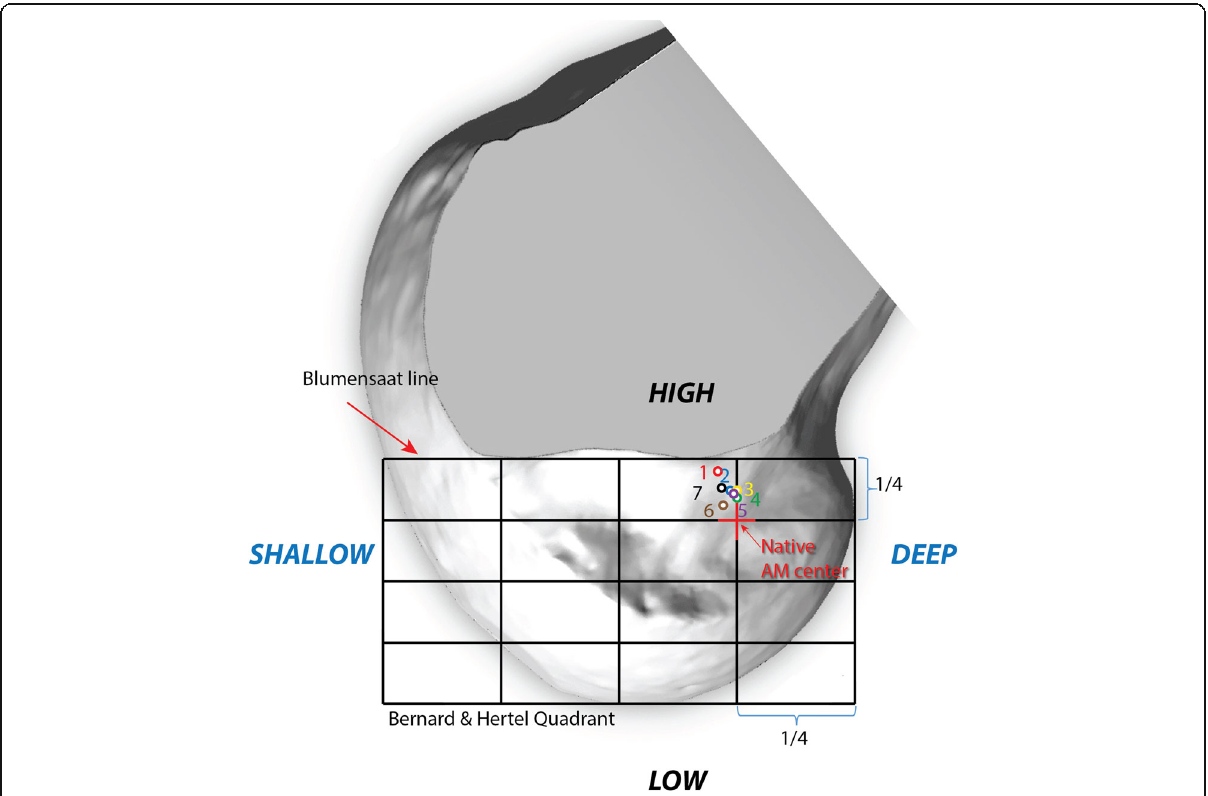
Fig. 6 Right femur: mapping each tunnel center measures (1 to 7). The Bernard & Hertel quadrant is drawn in the black grid. The center of the AM direct fibers of the ACL is placed at the Red Cross situated one quarter from the top and one quarter from the posterior part of the B&H grid. The upper part of the grid is the Blumensaat